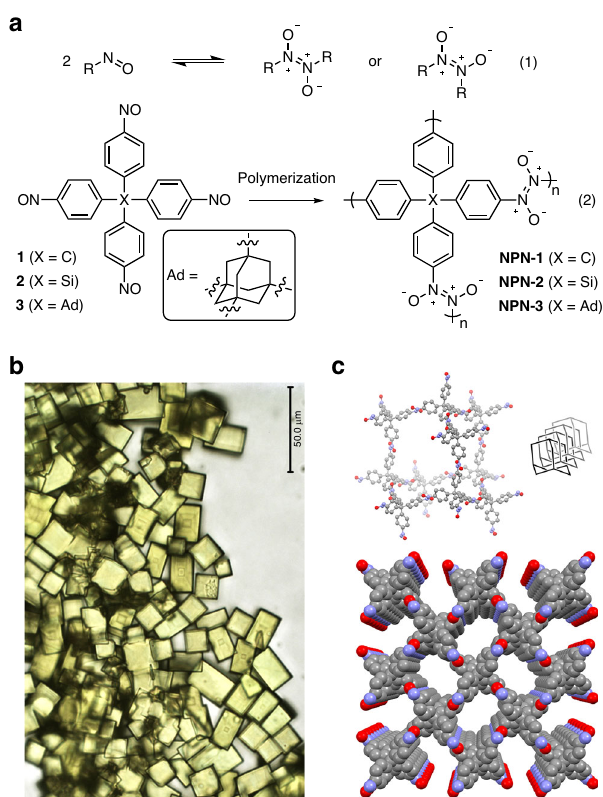
Fig. 6 Producing single crystals of a covalently bonded network. a Conversion of nitroso compounds into azodioxy dimers and polymers. b Crystals of the azodioxy polymer derived from nitroso monomer 1 . Adapted with permission from Springer Nature, ref. 52 . c Fourfold interpenetrated diamondoid structure of the polymer, as determined by single-crystal XRD. Channels appear along the c -axis, guests and atoms of hydrogen are omitted for clarity, and other atoms are shown in standard colors. Adapted with permission from Springer Nature, ref. 52